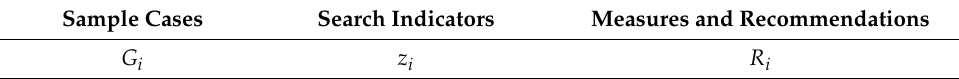
Table 1. Case representation.